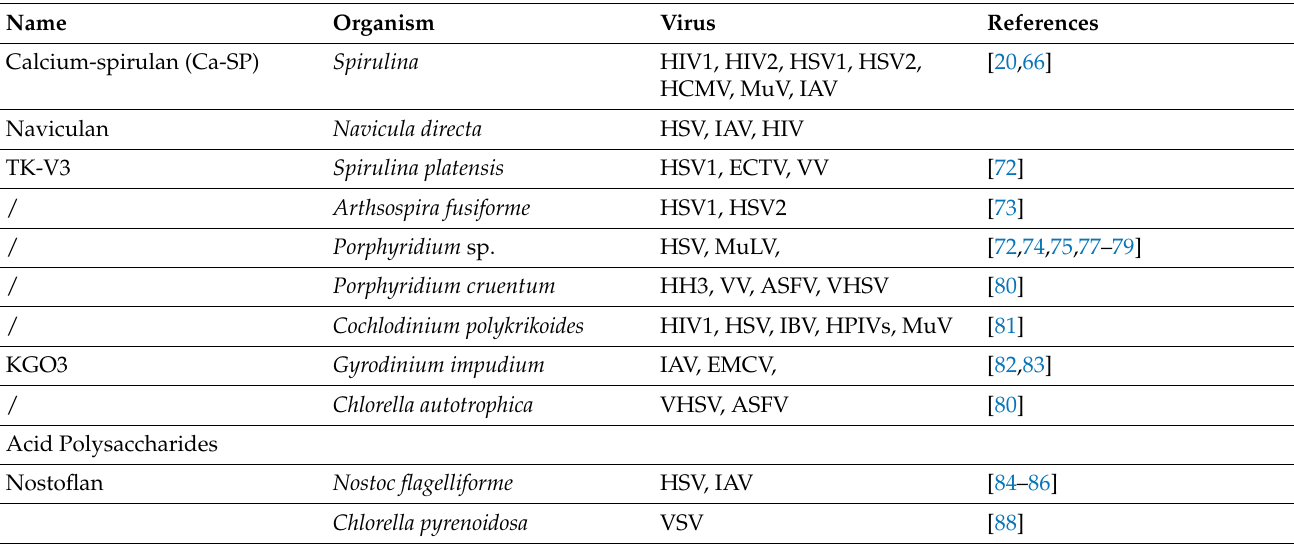
Table 2. Microalgae polysaccharides with antiviral